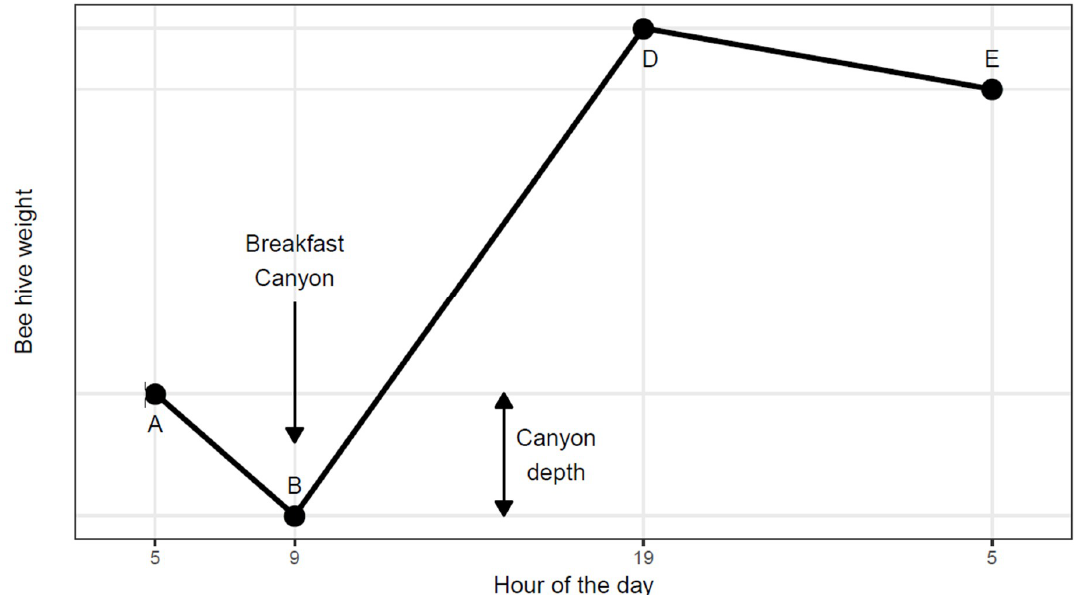
Figure 1. Hambleton’s Graph [1] with Breakfast Canyon added shows the daily pattern of beehive weight during a nectar flow. Abrupt changes in slope occur at A, B, D and E. The canyon has a depth (kg) equal to the weight at A minus the weight at B.